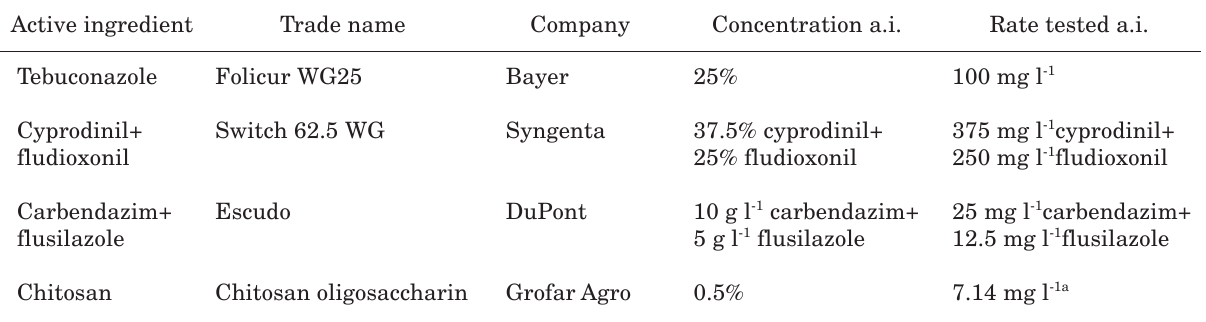
Table 2. Characteristics of fungicides and chitosan tested against Neonectria liriodendri and Phaeomoniella chlamy- dospora in in vivo